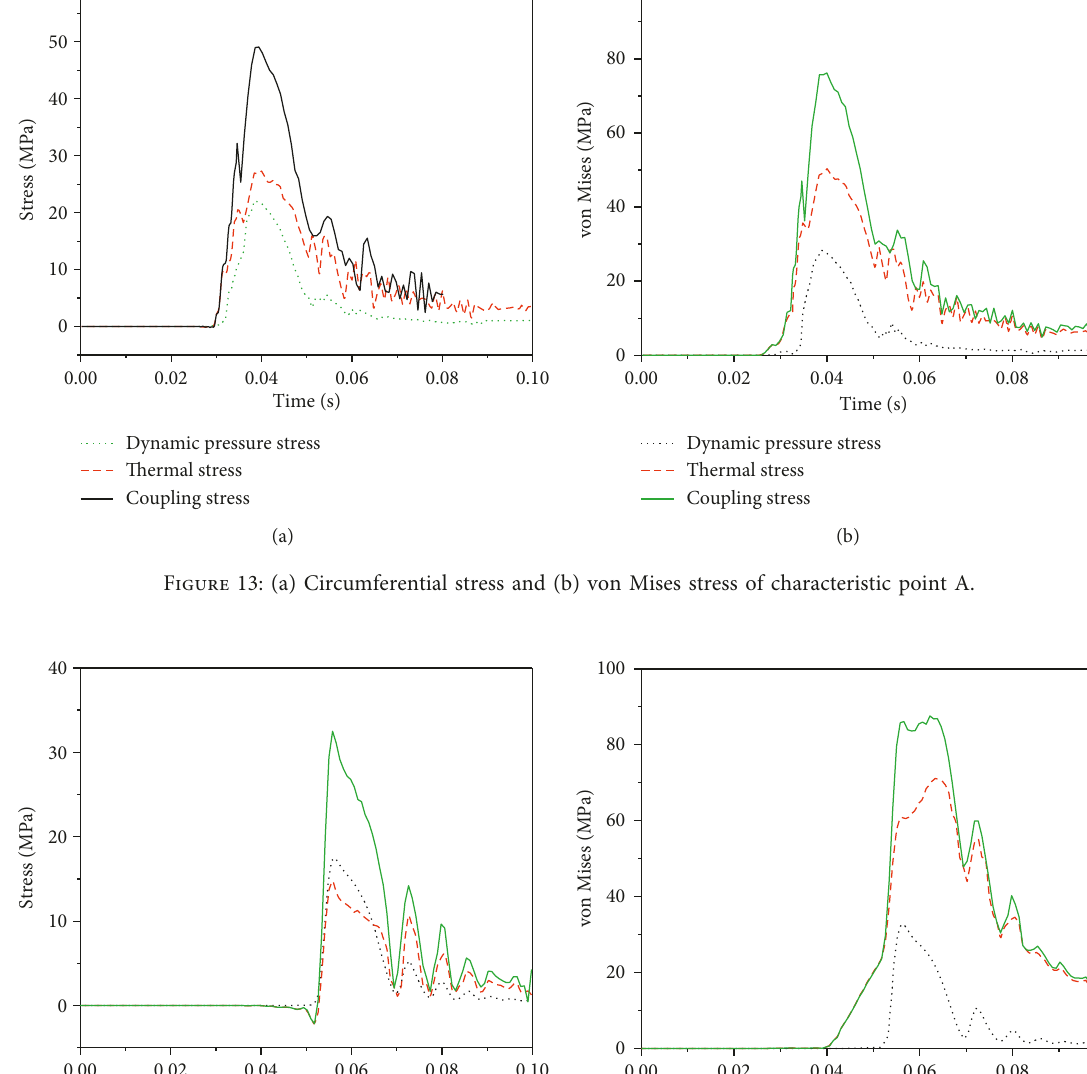
Figure 14: (a) Circumferential stress and (b) von Mises stress of characteristic point B.